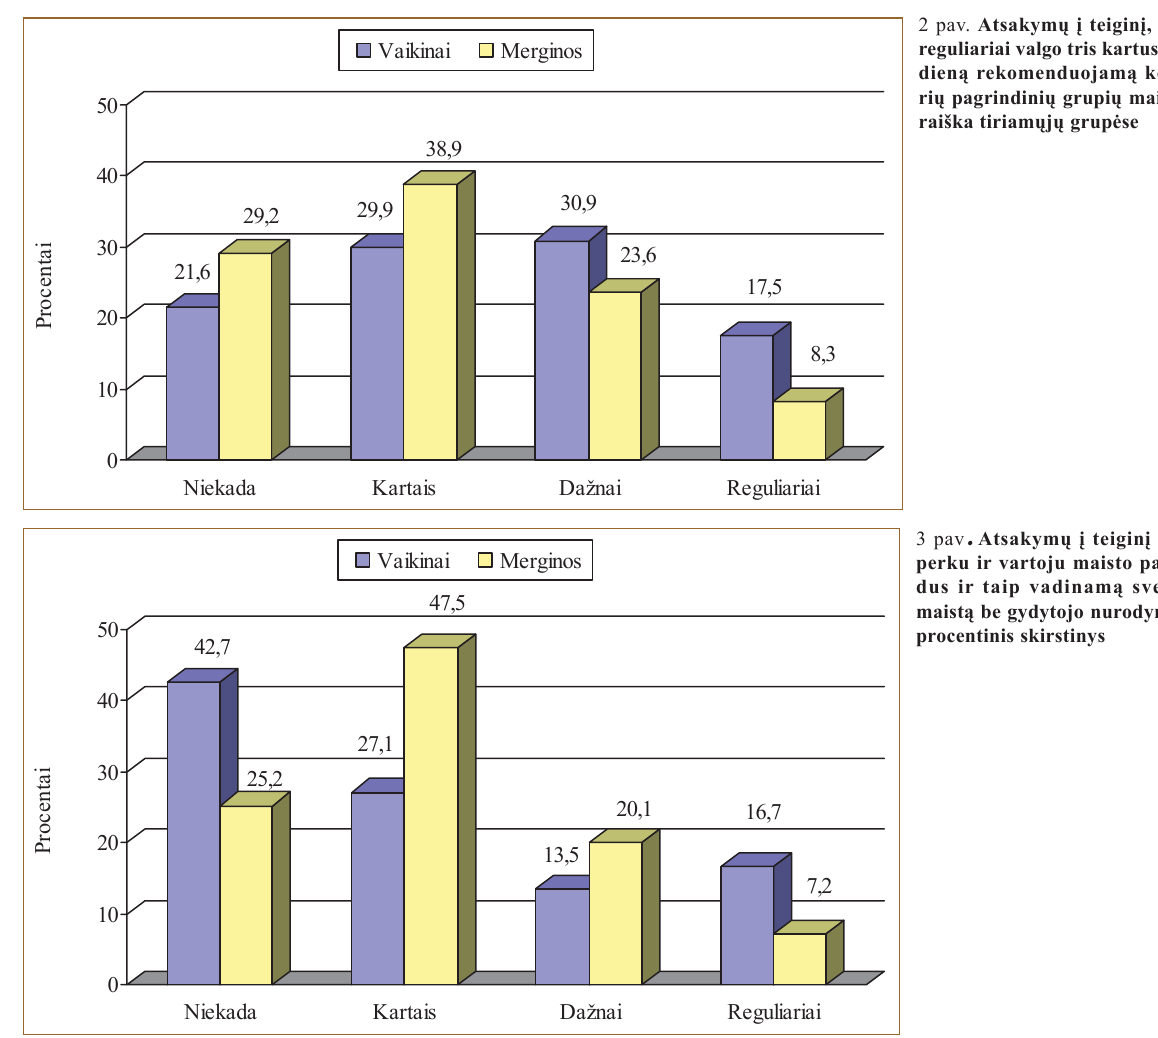
da neprisisega saugos dirž ų ir nesilaiko leistino grei č io. Kad vaikin ų pirmosios pagalbos į g ū džiai ge- resni negu mergin ų , matyti iš apklausos duome- n ų — nelaim ė s atveju savarankiškai ir efektyviai gal ė t ų atlikti širdies masaž ą 50,6% vaikin ų ir 27,5% mergin ų ( χ 2 = 12,4; p < 0,05). Taip pat daugiau vaikin ų negu mergin ų (51,2 ir 32,8%; χ 2 = 7,4; p < 0,05) pažym ė jo, kad nelaim ė s atveju jie gal ė t ų atlikti ir dirbtin į kv ė pavim ą . Savo ruožtu merginos labiau negu vaikinai domisi informacija apie produktus, t. y. perskaito produkt ų etiketes (informacinius lapelius). Kad niekada neskaito produkt ų etike č i ų , nurod ė 23,7% vaikin ų ir 10,6% mergin ų ( χ 2 = 8,2; p < 0,05). Nors daugiau vaikin ų nurod ė , kad reguliariai perka bei vartoja maisto papildus ir taip vadinam ą sveik ą maist ą be gydytojo nurodym ų (žr. 3 pav.), ta č iau kur kas daugiau j ų niekada neperka toki ų produkt ų ( χ 2 = 12,4; p <